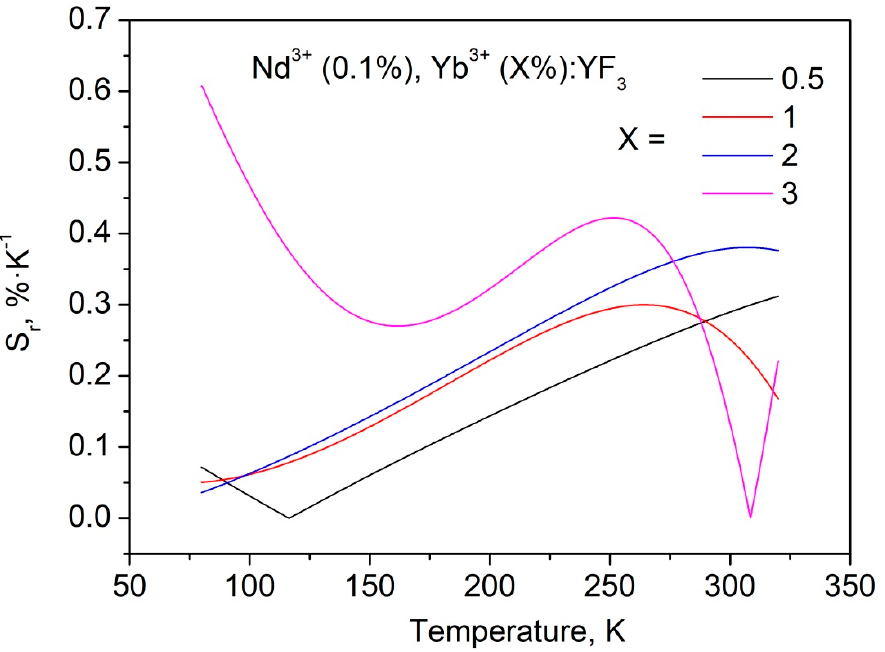
Figure 7. S r as functions of temperature obtained from LIR curves for Nd 3+ (0.1 mol.%), Yb 3+ (X mol.%):YF 3 samples.